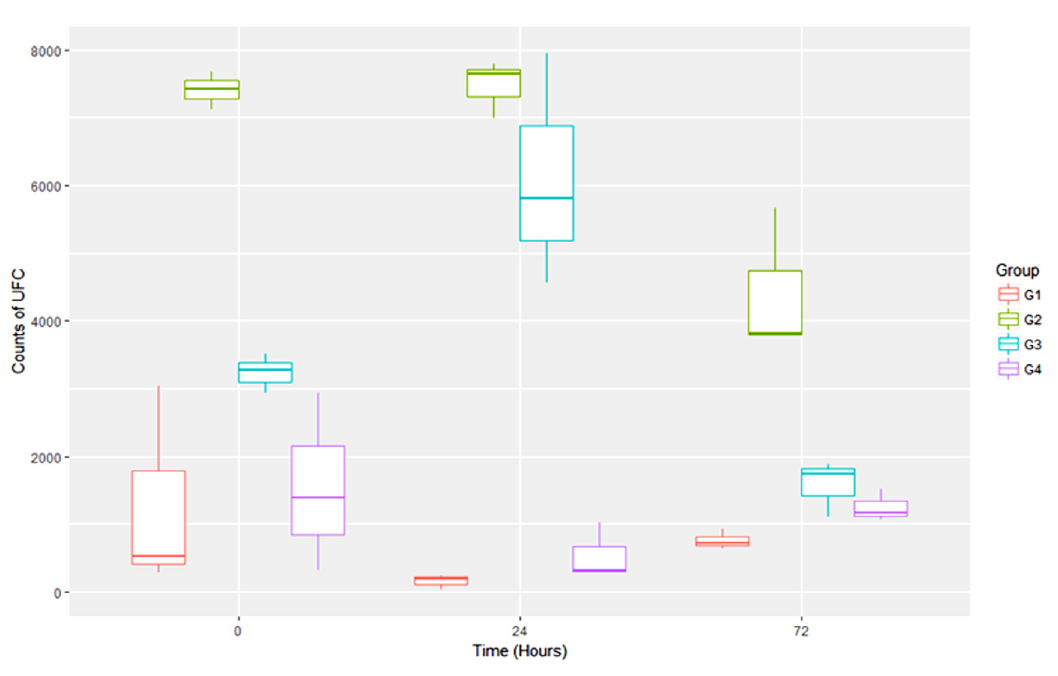
FIGURE 2 - Box-Plot: UFC vs Time for Group. Group 1 (G1), A positive control group treated with 800 µL of thioglycolate + 200 µL of NaOCl 5.25%; group 2 (G2), 1 mL of thioglycolate + laser irradiation (8 min, 33 sec); group 3 (G3), 1 mL δ -ALA (40 µg/mL)-thioglycolate solution; and Group 4 (G4), 1 mL of δ -ALA (80 µg/mL)-thioglycolate solution + laser irradiation